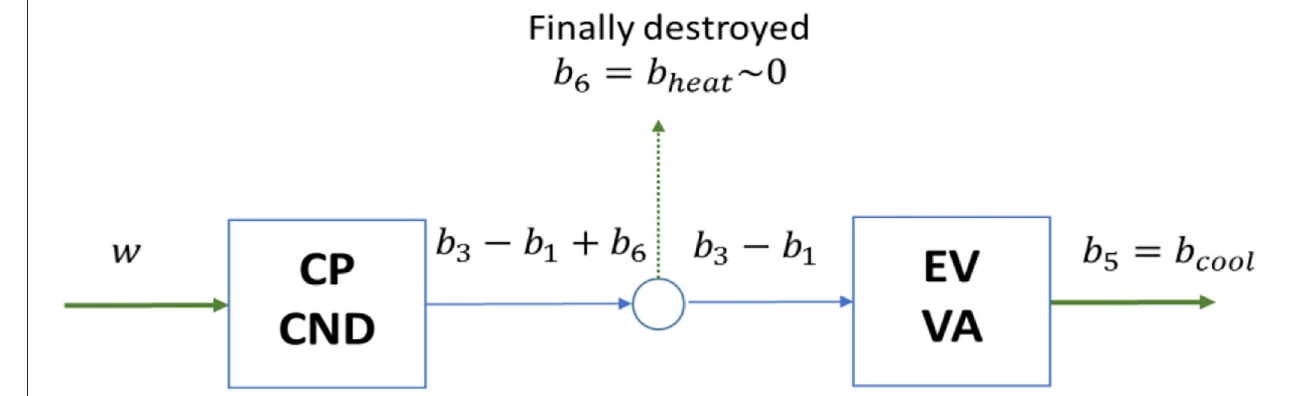
FIGURE 4 | E Model approach.